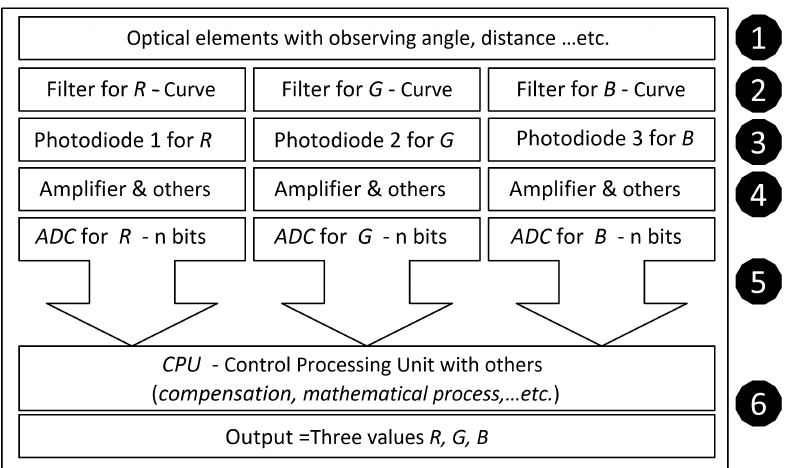
Figure 2. Structural components and functions of the six structural layers of an RGB color sensor.